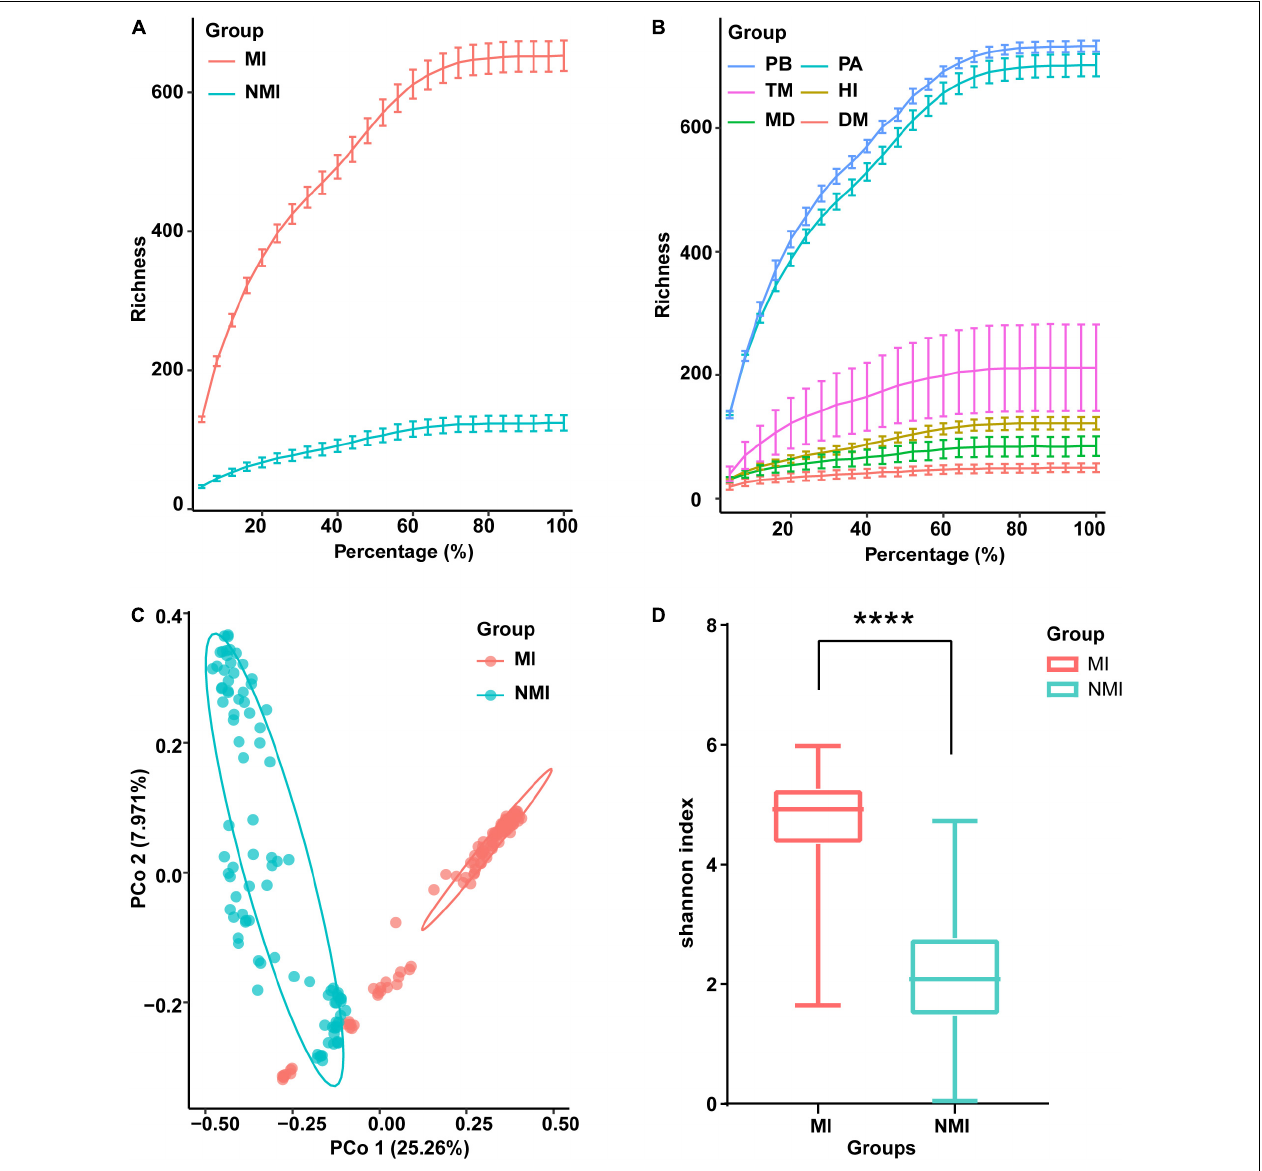
FIGURE 1 | Data survey on the gut microbiota of the medicinal insects (MI) and the non-medicinal insects (NMI). (A,B) Data rarefaction curves of gut microbiota in the medicinal insect group (MI) and the non-medicinal insect group (NMI) (A) and in each species (B) . In the rarefaction curves, the horizontal axis represents the proportion of selected OTUs (%) and the vertical axis shows the species richness (number of OTUs); error bars represent Standard Error of Mean (s.e.m). PB, Protaetia ( Liocola ) brevitarsis (Lewis); PA, Periplaneta americana ; TM, Tenebrio molitor ; HI, Hermetia illucens L.; MD, Musca domestica ; DM, Drosophila melanogaster . (C) Unconstrained principal coordinate analysis (PCoA) based on Bray–Curtis distance between samples, showing the gut microbiota of medicinal insects and non-medicinal insects roughly separated [ p < 0.0001, permutational multivariate analysis of variance (PERMANOVA) by Adonis]. (D) Shannon index showing species diversity within samples of the gut microbiota of medicinal insect group and non-medicinal insect group. The horizontal bar in the box plot represents the median, the upper and lower marginal lines represent the upper and lower quartiles (75th and 25th quartiles), and the extended lines on the margins are the extreme values in the absence of outliers, but not exceeding 1.5 times the distribution interval of the upper and lower quartiles. We use t -test to compare the differences between groups ( p < 0.0001), and the symbol “****” on the graph indicates significant differences between